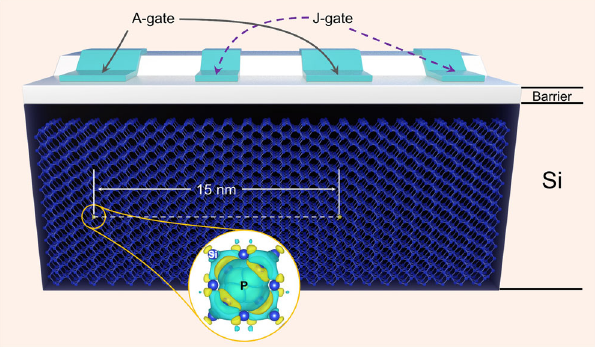
Fig. 1 Illustration of single P donor in Si host in a quantum information processor. A-gates above the donors control the hyper fi ne coupling and hence the resonance frequency of the nuclear spin qubits; J-gates between the donors control the electron-mediated coupling between adjacent nuclear spins. The black background Si region below the barrier is used to re fl ect a more bulk-like scenario for qubits embedded into Si at depths >10 nm. The embedded charge density difference map illustrates the electronic interaction around the donors (isosurface value of 1 × 10 − 3 e/ Å 3 ), where cyan area represents electron depletion and yellow area represents electron